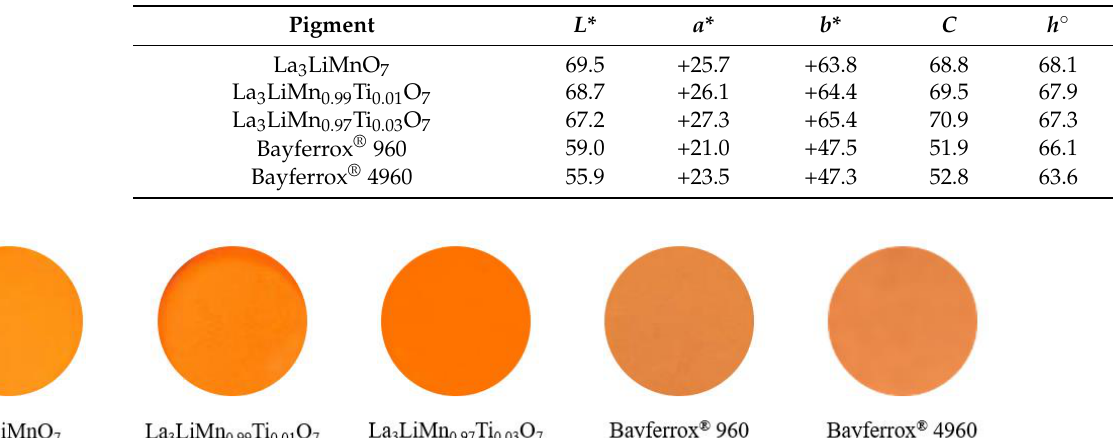
Table 3. L * a * b * Ch ° color coordinate data of the La 3 LiMn 1− x Ti x O 7 (0 ≤ x ≤ 0.03) and commercially available orange (Bayfer- rox ® 960 and Bayferrox ® 4960) pigments. Pigment